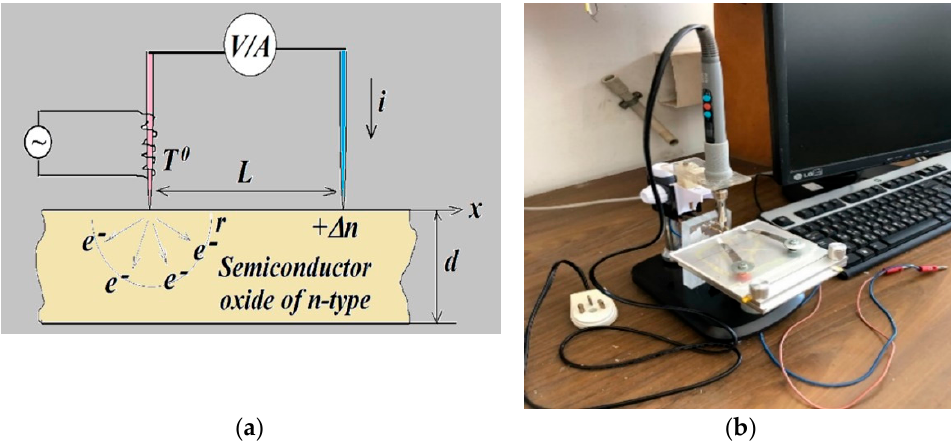
Figure 1. The laboratory setup for dynamic hot-probe measurements: ( a ) the principal operation scheme; ( b ) the laboratory home-made measurement setup.